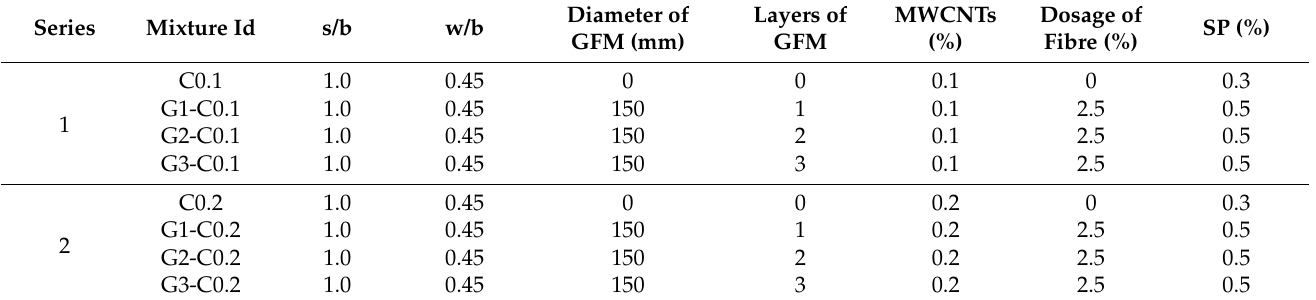
Table 1. Mixing composition of TECAFC.